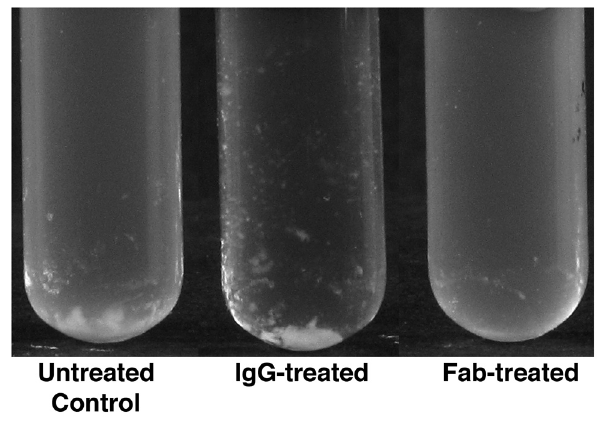
Figure 2. IgG antibodies to enterococcal aggregation sub- stance enhance aggregation of E.faecalis in vitro, whereas Fabs prevent aggregation.